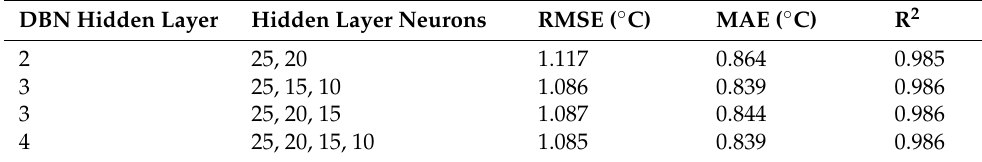
Table 4. DBN model performance for different layers and neurons.